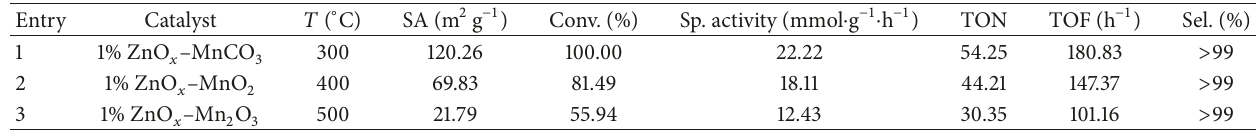
of reaction time. Table 2: Effect of different weight % of ZnO 𝑥 on the 1-phenylethanol oxidation. [ a ]